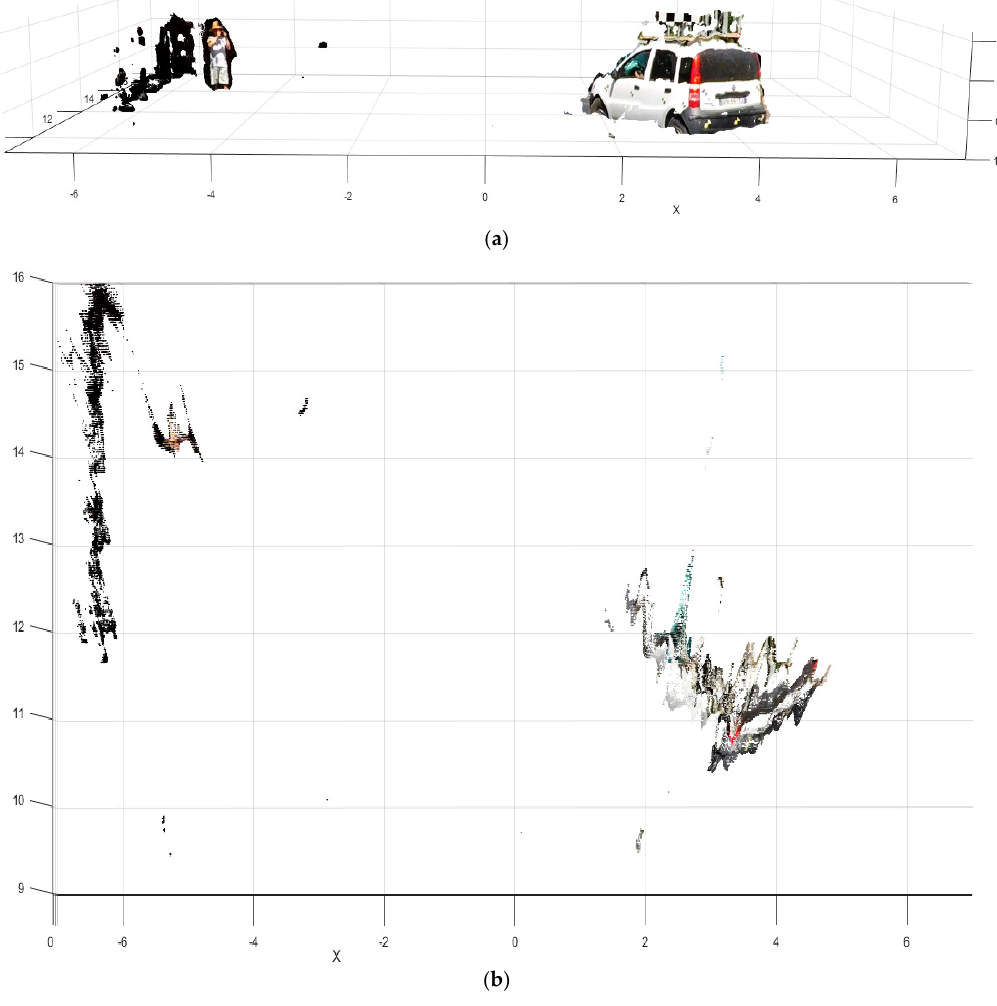
Figure 13. Detail of 3D reconstruction of the pre-crash scene (id90–InSAFE). ( a ) Cleaned 3D point